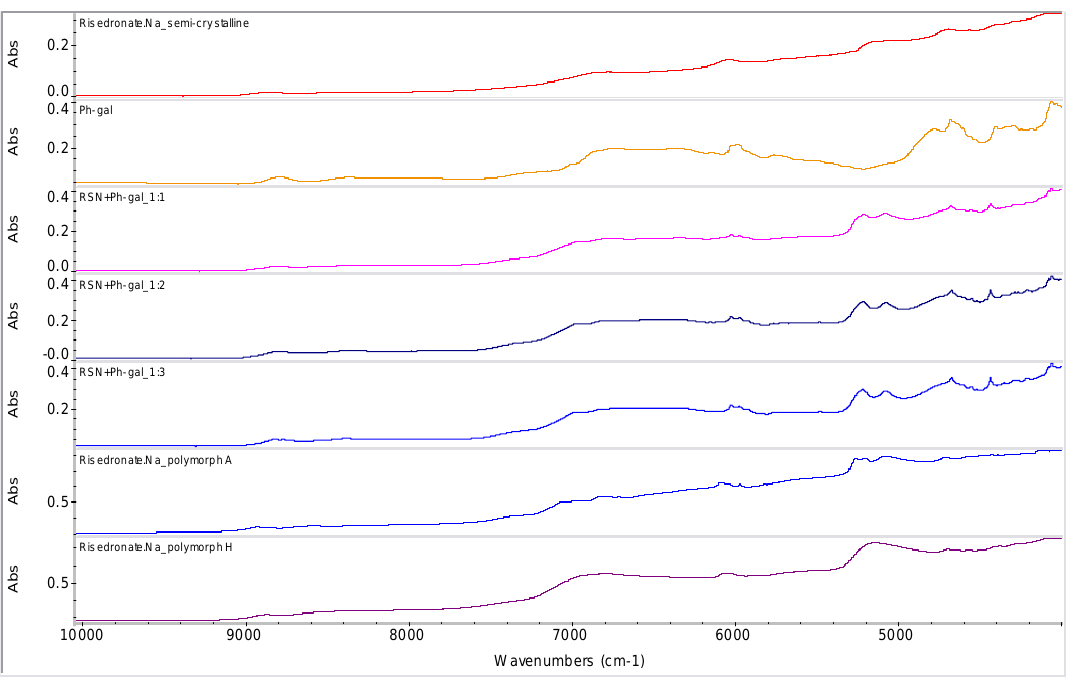
Figure 11. NIR spectra of semi-crystalline risedronate monosodium salt (RSN), forms A and H and phenyl- β - D -galactopyranoside (Ph-gal) and spectra of their mixtures in ratios 1:2 and 1:3 prepared by methanol precipitation (samples 4 , 5